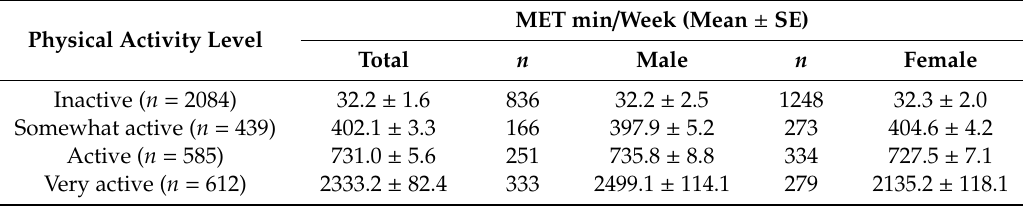
Table 4. Classification of physical activity levels.